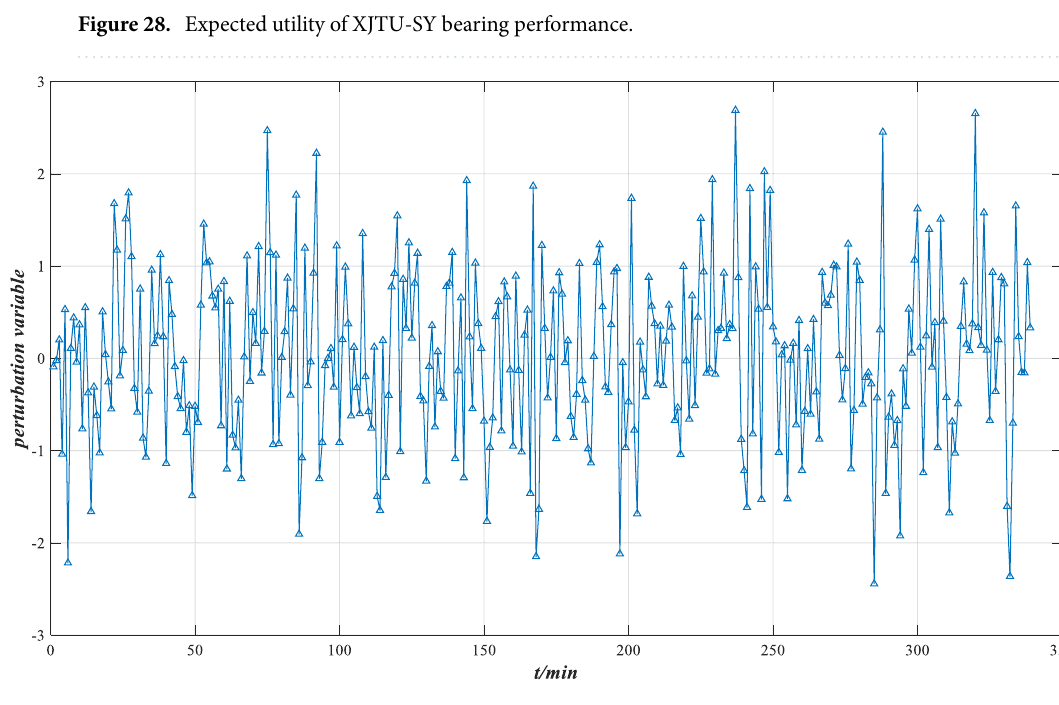
Figure 29. Perturbation variable